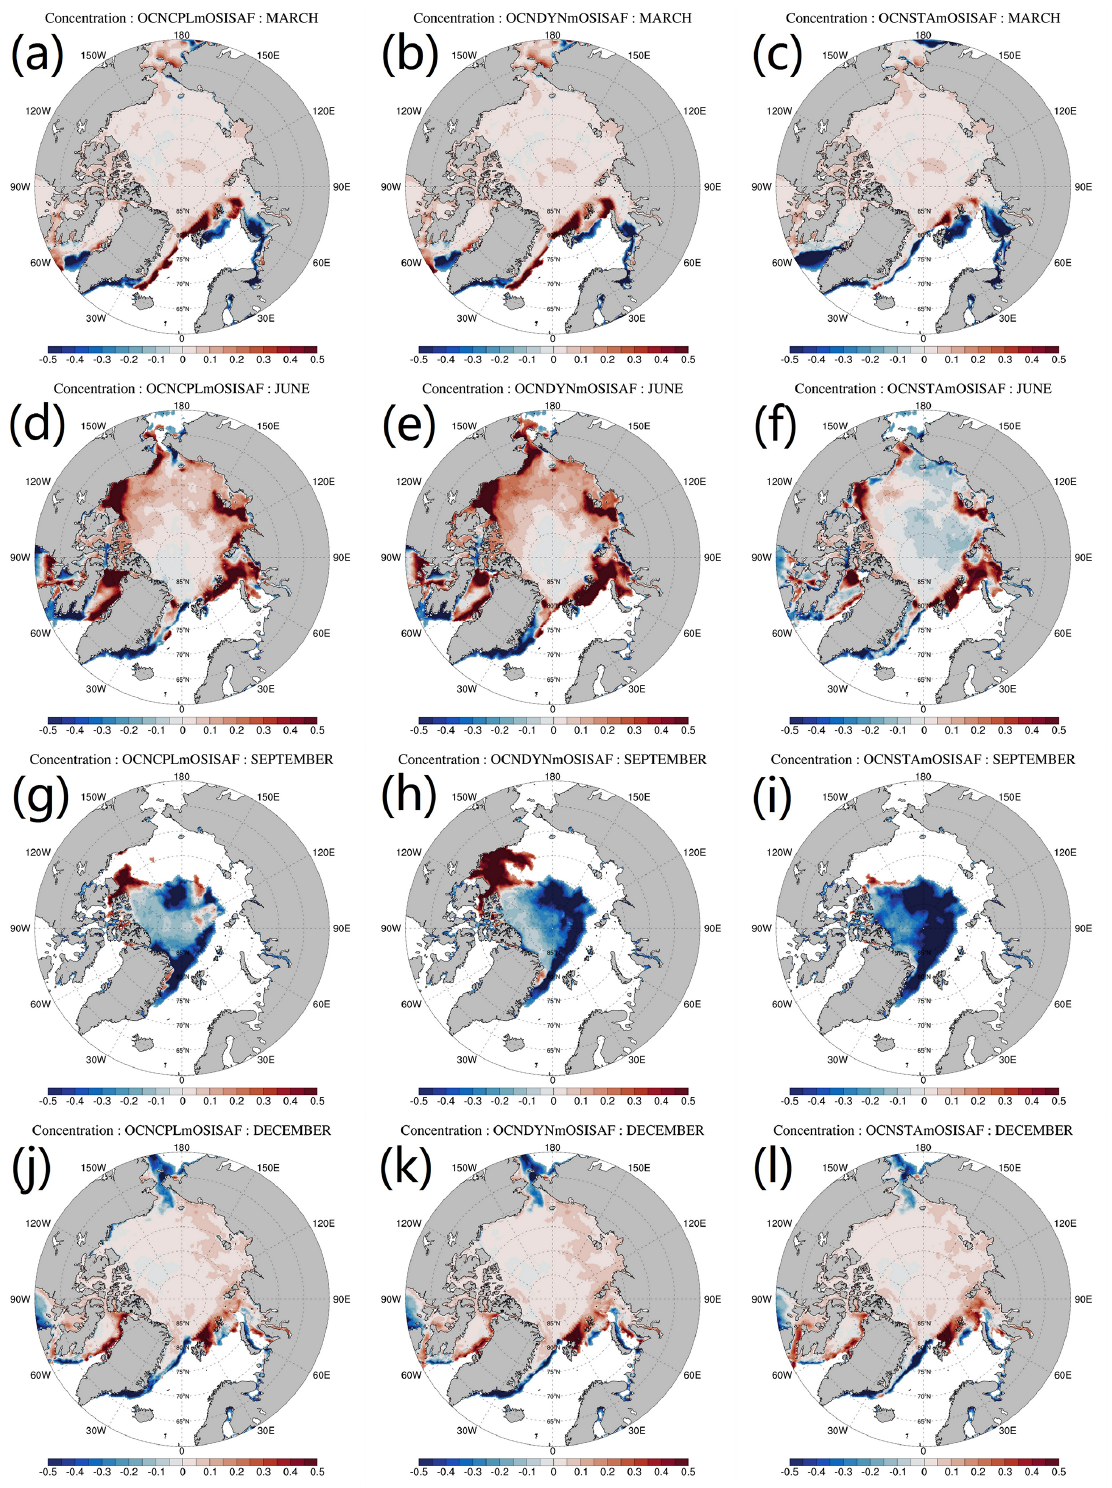
Figure 8. Deviation between the modeled and observed monthly mean sea ice concentration. From top to bottom panels show the March, June, September and December sea ice concentration deviation respect to the OSISAF observations, respectively. The left, middle and right panels show results of the OCNCPL run, the OCNDYN run and the OCNSTA run. OSISAF: Ocean and Sea Ice Satellite Application